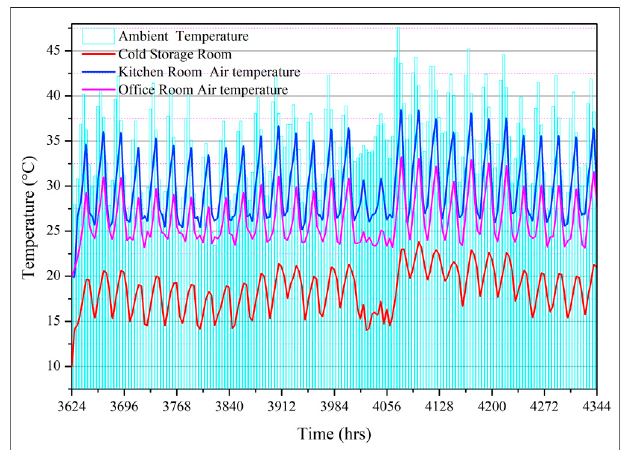
FIGURE 8 | Ambient air, cold storage, of fi ce and kitchen room temperature ( °